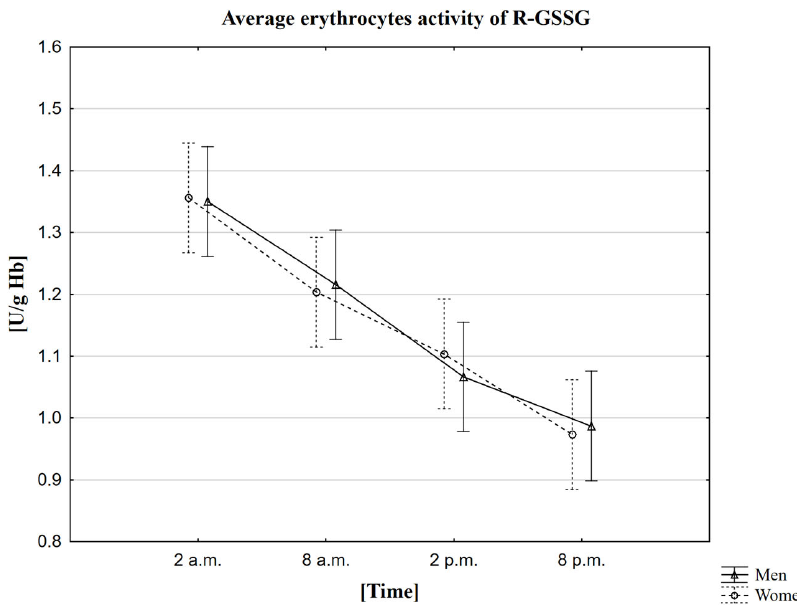
Table 6. Parameters describing the activity of glutathione reductase (R ‐ GSSG) in women and men, including the time of blood collection (U/g Hb).